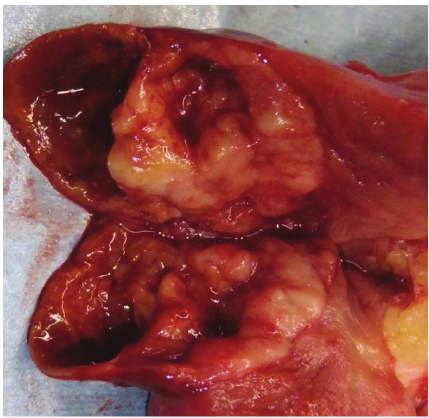
Figure 2: Macroscopic findings. The gross features of the resected tumor included a white-yellow soft mass attached to a cystic lesion.